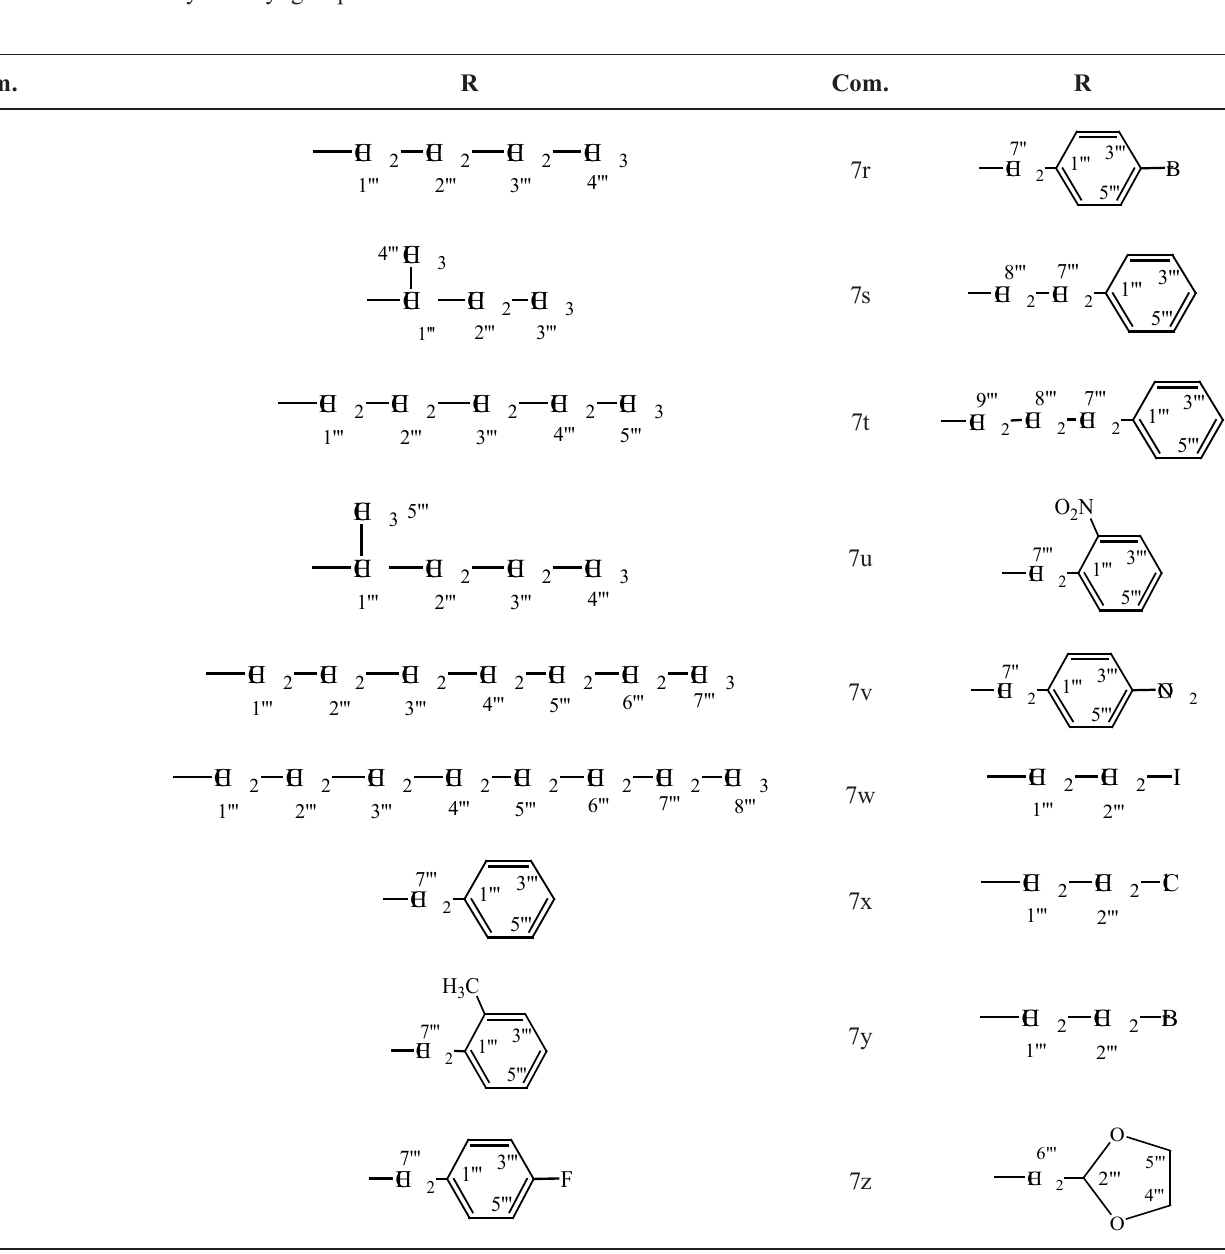
TABLE I - D ifferent alkyl/aralkyl groups